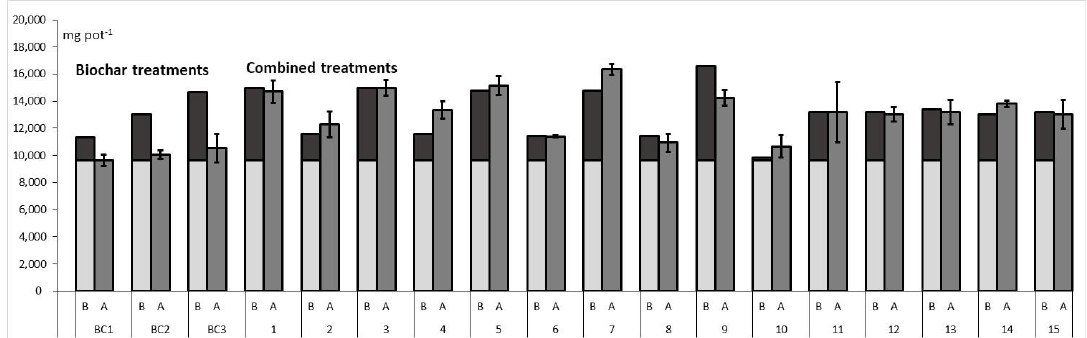
Figure 1. Comparison of soil OM content measured at the beginning of (B) and after (A) the experiment in the different treatments. Treatments 1 – 15: combined treatments, BC1 – 3: separate biochar treatments. Treatment doses can be seen in Table 2. Legend: light grey: original soil OM content; dark grey: OM added in individual treatments; medium grey: OM content measured in the soil after the experiment.